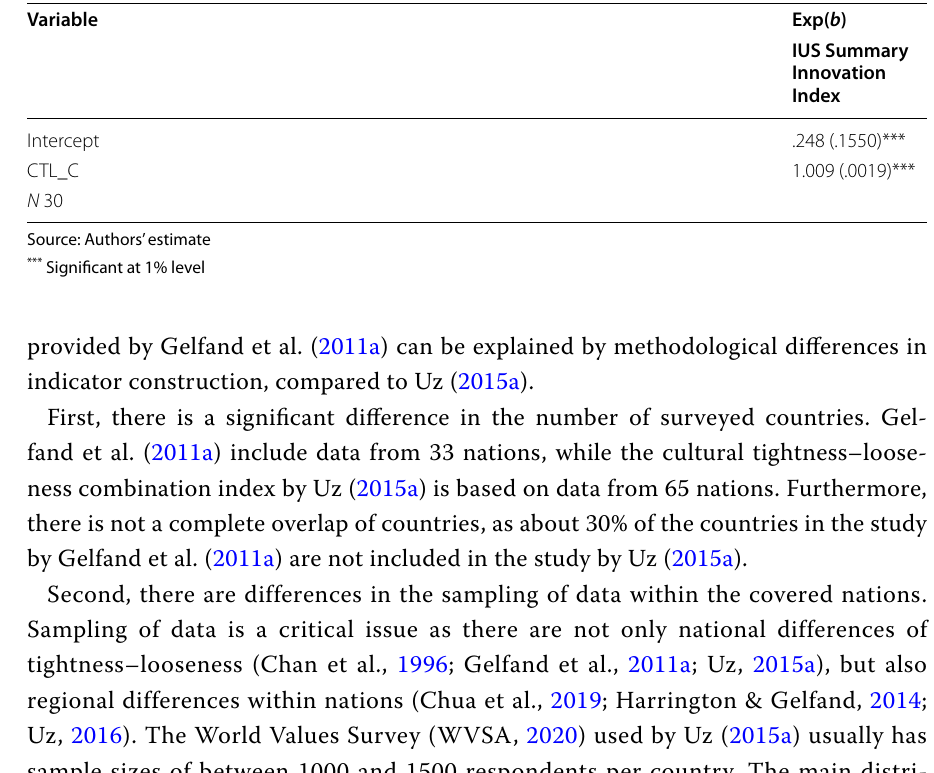
Table 8 Regression IUS Summary Innovation Index 2013